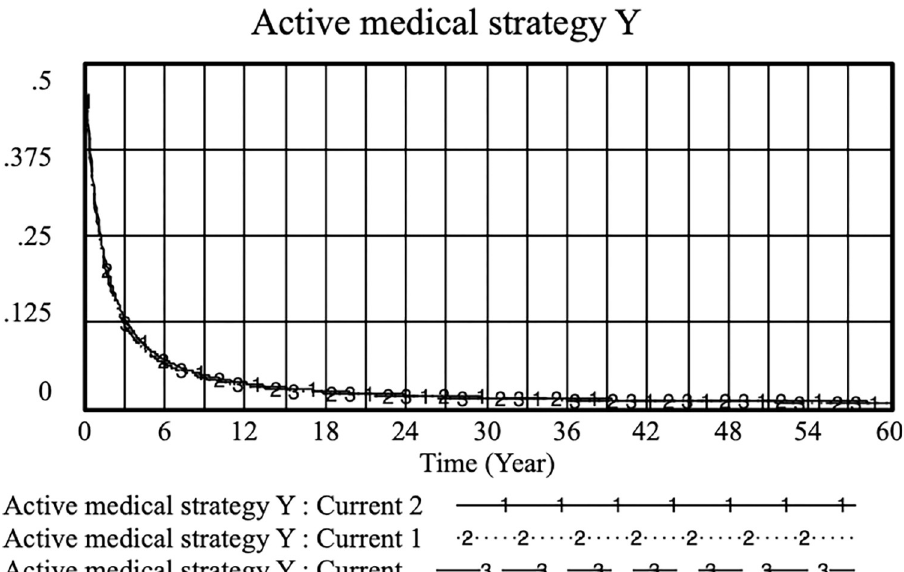
Fig 6. Effects of E and PE 1 on the choice of active medical strategies for physicians. (current: E = 0.3, PE 1 = 0.5; current 1: E = 0.4, PE 1 = 0.5; current 2: E = 0.4, PE 1 = 0.6).